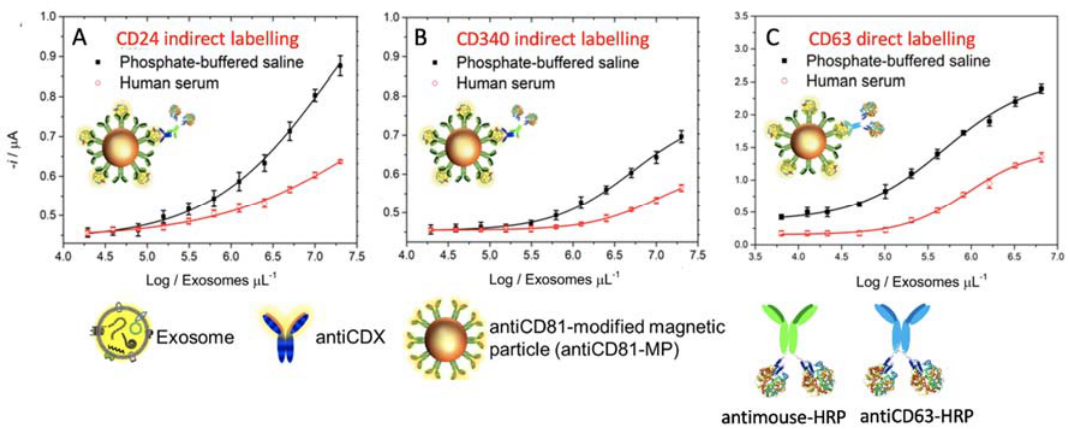
Figure 10. Electrochemical immunosensor for the detection of exosomes derived from the SKBr3 breast cancer cell line spiked in exosome ‐ depleted human serum and a phosphate buffer. IMS of the exosomes on antiCD81 ‐ MPs, followed by indirect labeling with ( A ) antiCD24, ( B ) antiCD340 and by direct labeling with ( C ) antiCD63 ‐ HRP antibody. In all cases, the concentration of MPs was fixed in 1 × 10 6 MPs, 0.50 μ g mL − 1 of primary antibody, 0.08 ng mL − 1 of antimouse ‐ HRP and 1.24 μ g mL − 1 of antiCD63 ‐ HRP antibody. Enzymatic electrochemical signals were monitored at − 0.1 V vs. Ag/AgCl (sat.) . In all cases, the replicates were obtained with three different samples measured with different m ‐ GEC electrodes. The error bars show the standard deviation for n = 3.